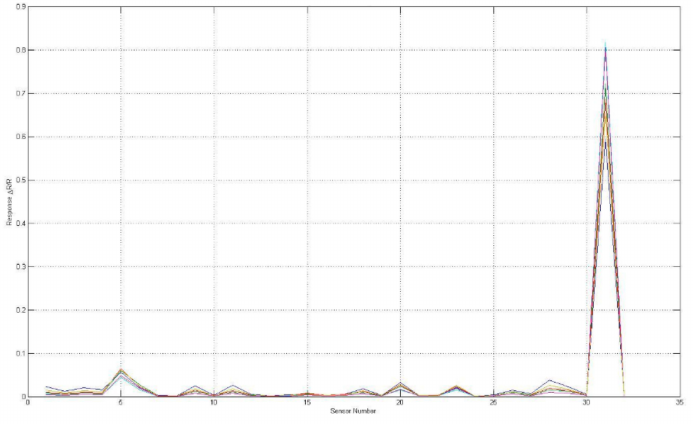
Figure 3. Sensorgram of the sensors’ responses to F-MC made with milk from Holstein cows (CTF).